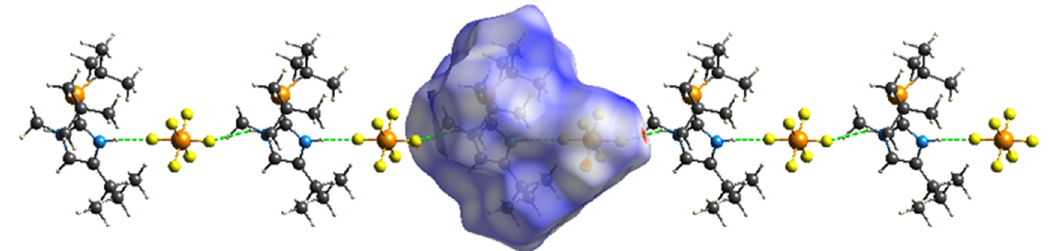
Figure 4. Halogen–hydrogen interaction (seen along the c-axis) leading to 1-D chain along b- axis.